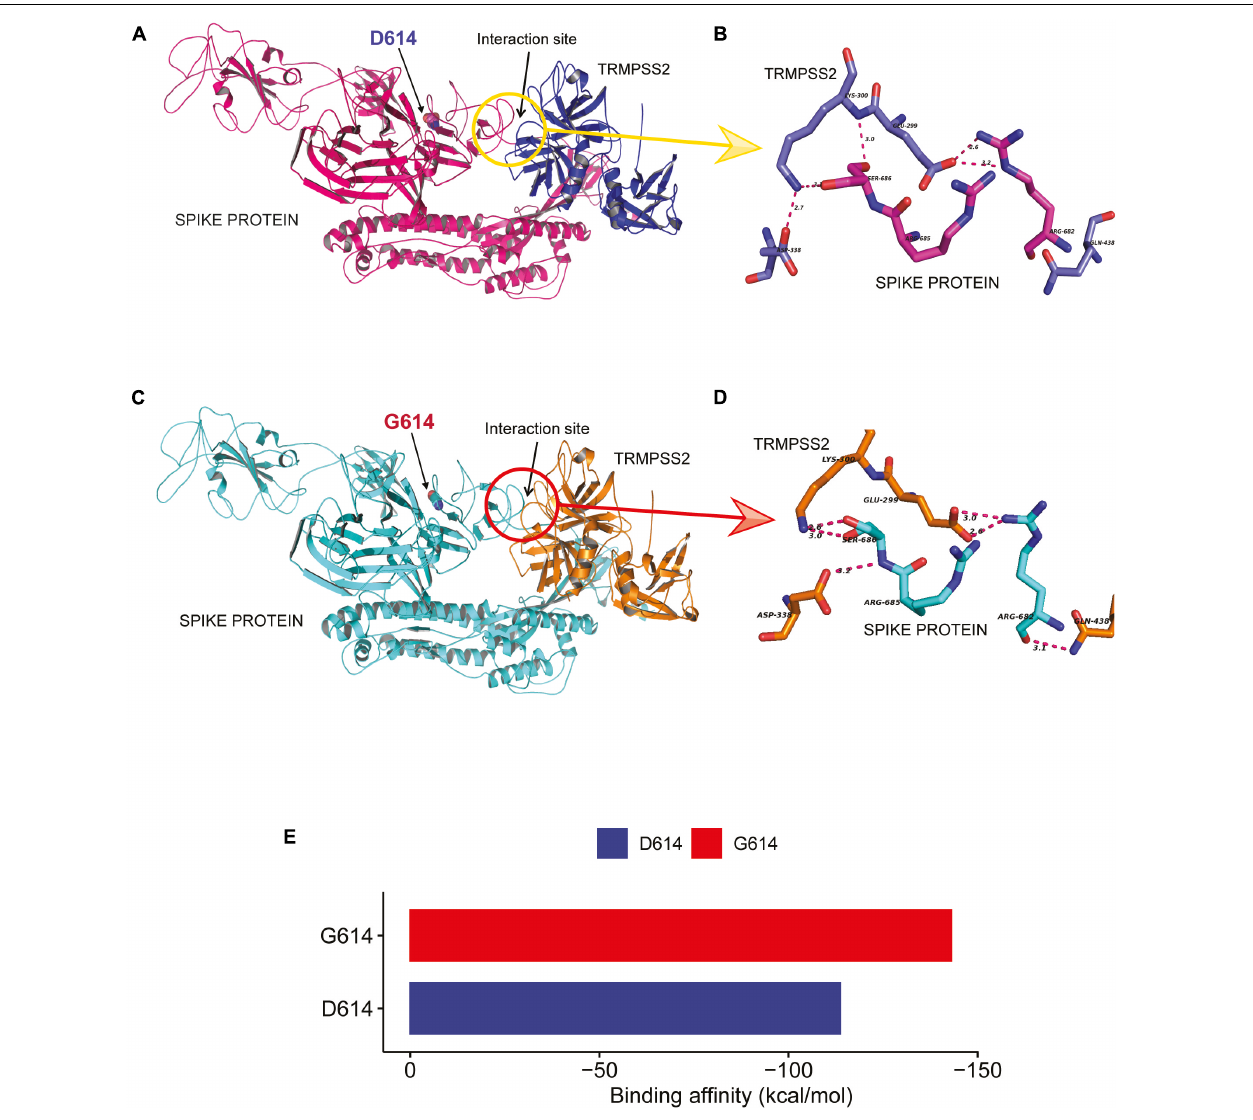
FIGURE 5 | D614G change in Spike protein enhanced TMPRSS2 protease interaction that might be responsible for increased virus infectivity. (A–D) The docking study of TMPRSS2 with the wild-type (D614) and mutant (G614) Spike protein. The interaction site and the mutation position (614) is marked with an arrow. The hydrogen bond interactions are shown in pink dotted lines with distance marked in Å. (A) The overview of the docking site location on WT Spike protein, (B) the interactions between TMPRSS2 and wild type, (C) the overview of the docking site location on WT Spike protein, (D) the interactions between TMPRSS2 and mutant Spike protein, and (E) the average binding energy (kcal/mol) values for the top poses selected from five different clusters.